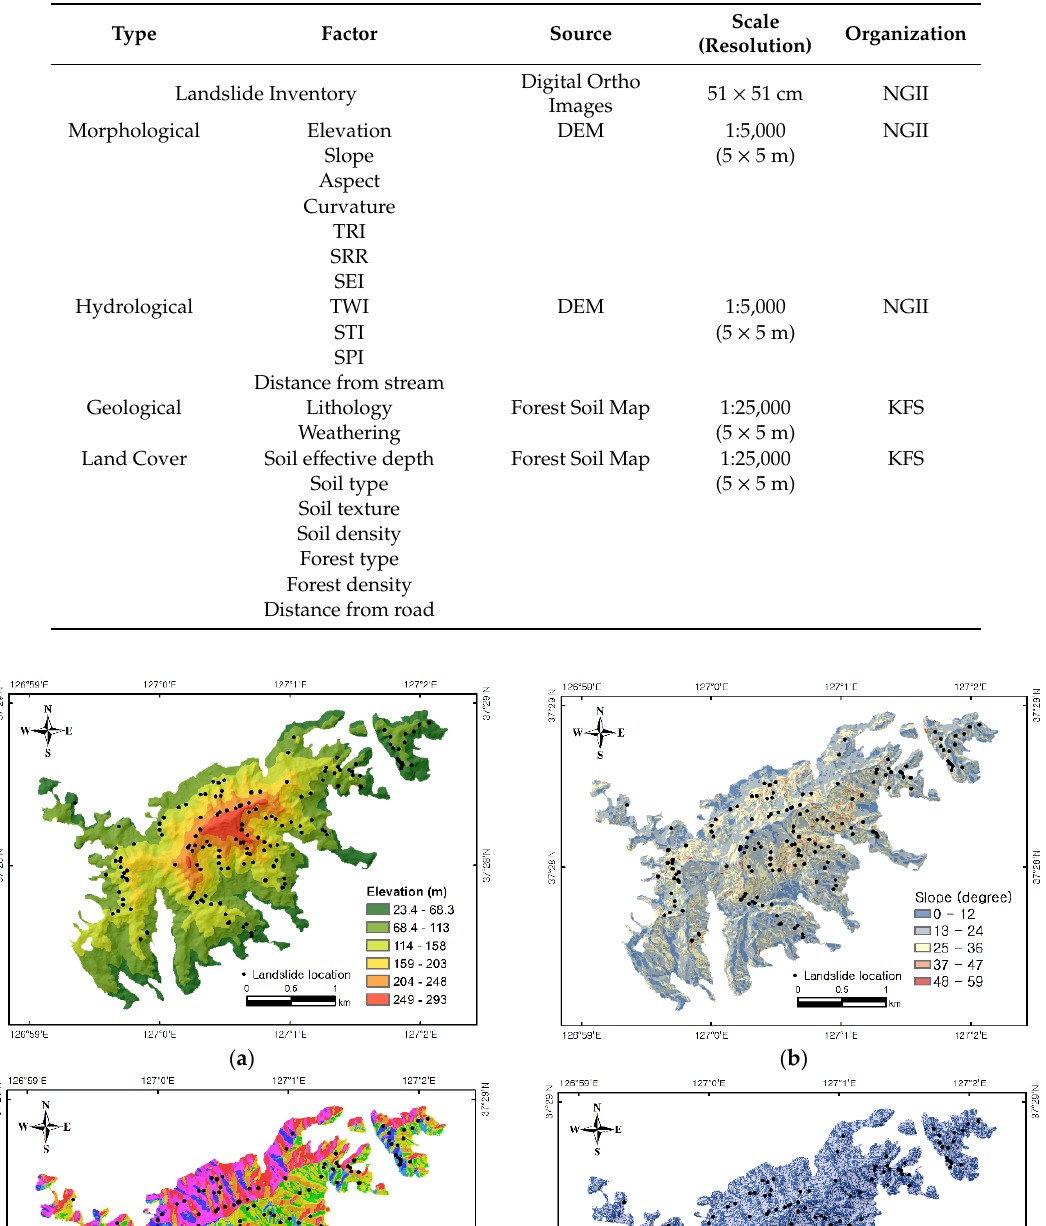
Table 1. Spatial database for the landslide susceptibility map.